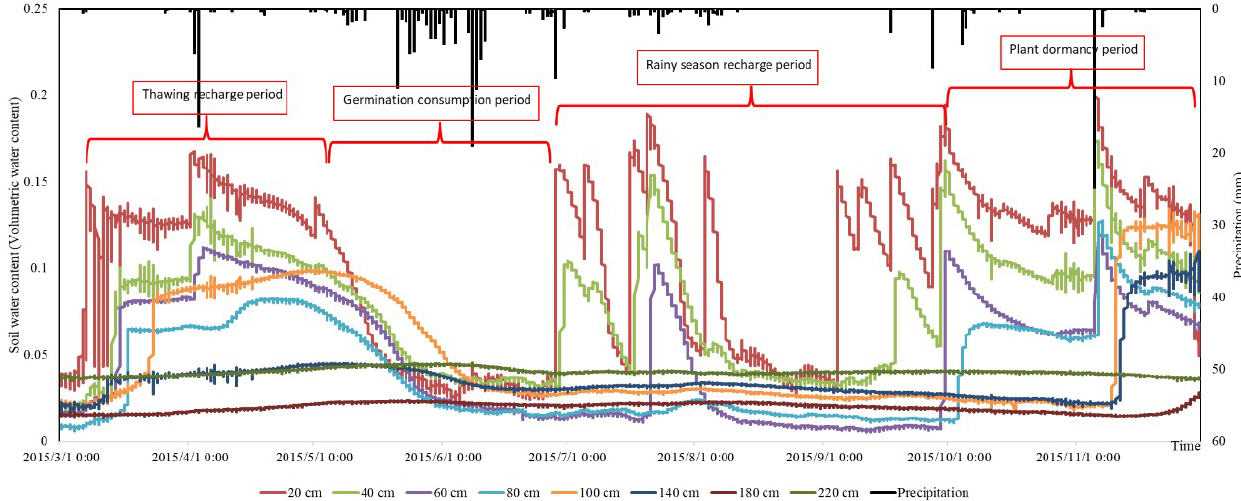
Figure 4. Daily soil water content distribution of the ASK plot in 2015.